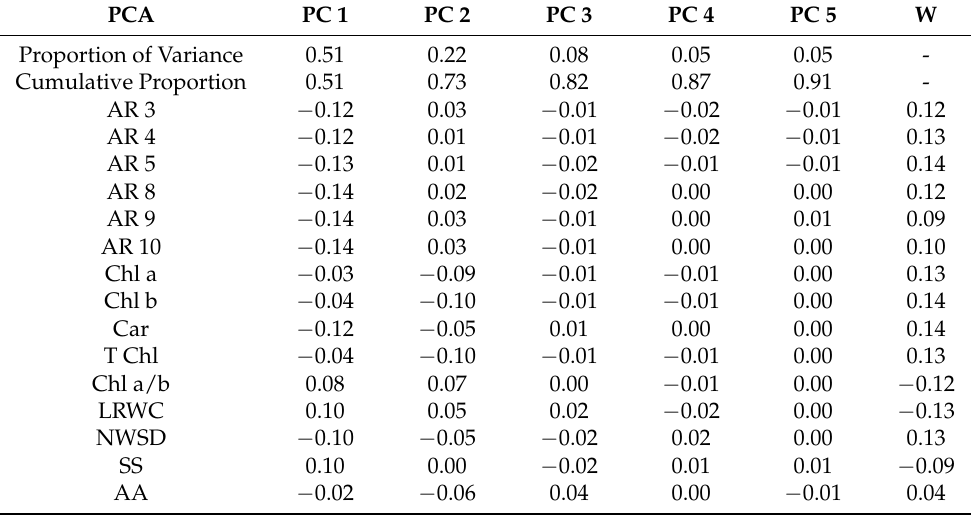
Table 1. Weight determination by principal components analysis